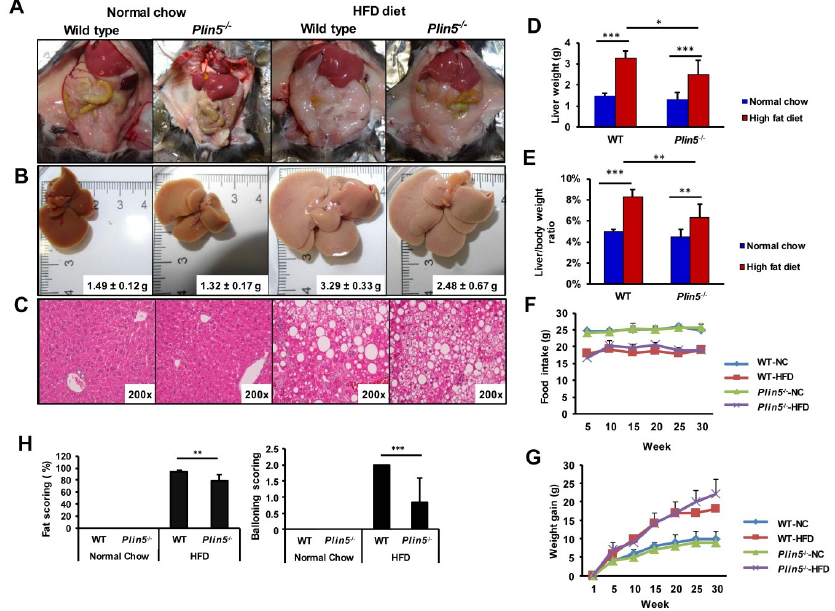
Figure 2. High-fat diet (HFD) induces less steatotic livers in Plin5 − / − mice. Wild type (WT) and Plin5 − / − mice fed either a normal chow or high-fat diet (HFD) for 30 weeks ( n = 4–7 animals/group). ( A ) Overall image of the ventral area of representative mice after 30 weeks of diet, where organs such as liver, adipose tissues and intestines are visible. ( B ) Macroscopic appearance of WT and Plin5 − / − livers where HFD-induced hepatomegaly and a paler color on the livers due to fat accumulation with a lower e ff ect on the Plin5 − / − livers are obvious. Average liver weight per group is indicated on the representative image. ( C ) Microscopic captions of liver sections’ histology stained with hematoxylin and eosin (200 × ). ( D ) Liver weight at time of sacrifice and ( E ) ratio of liver to body weight at the end of the experiment of all mice used. ( F ) Food intake and ( G ) weight gain per group monitored during the 30-week period. ( H ) Nonalcoholic fatty liver disease (NAFLD) scoring reveals less fat accumulation in the Plin5 − / − animals as well as fewer hepatocytes with ballooning degeneration after the HFD. Data are expressed as mean ± SD. Statistical analysis was performed with Student’s t -test. * p < 0.05; ** p < 0.01; *** p <